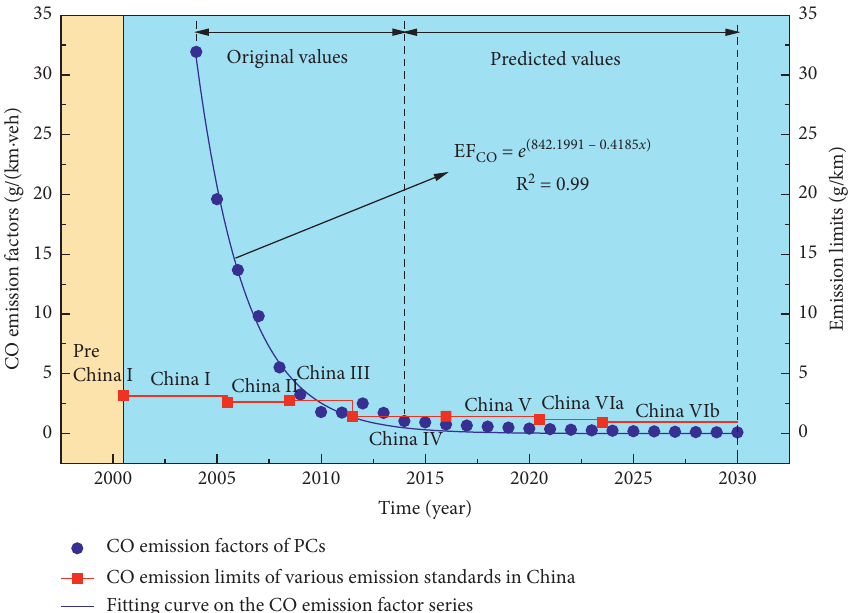
Figure 2: The developing changes of CO emission factors for passenger